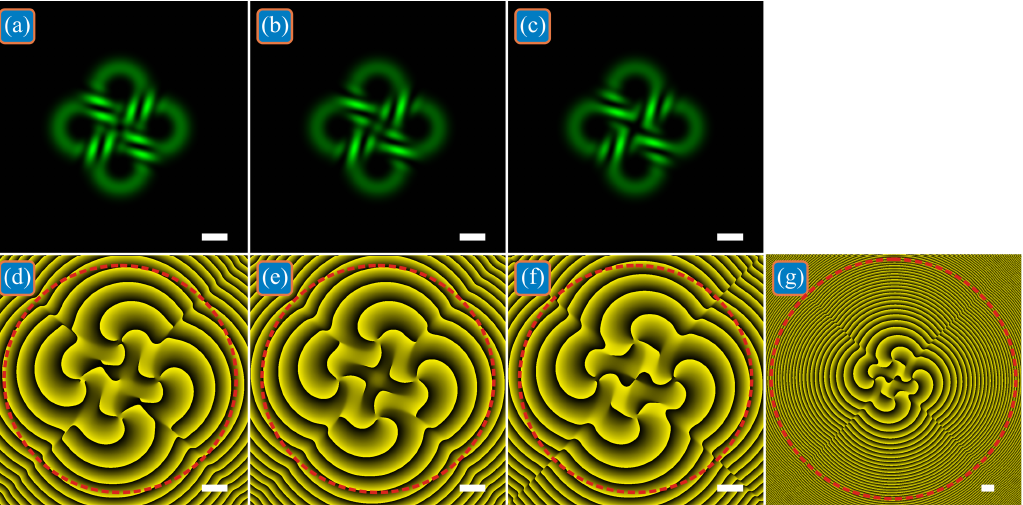
Figure 2. Intensities ( a – c ) and phases ( d – g ) of three superpositions of off-axis single-ring LG beams with the initial distribution shown in Figure 1 at the Rayleigh distance. The total TC of the superpositions is the same as that of each constituent beam ( a , d ), or differs from the TC of each beam by +1 ( b , e ) and by −1( c , f , g ) due to the presence of complex weight coefficients in the superposition.